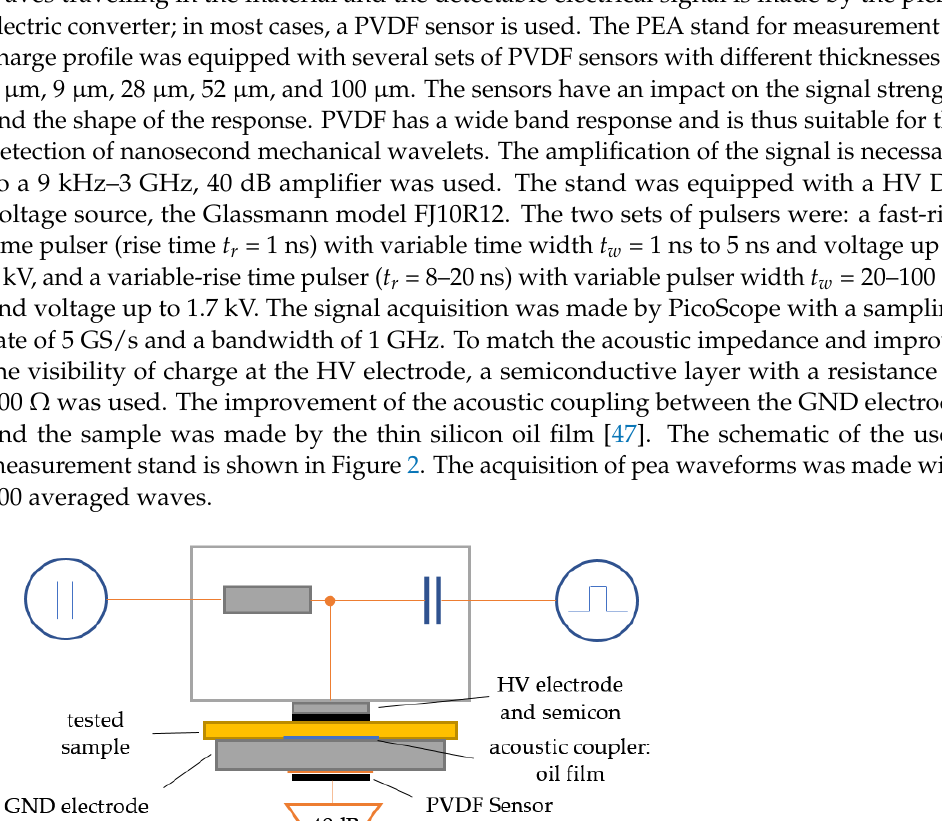
5 of 22 Figure 1. Algorithm for the determination of electrical field distribution based on the measurement of space charge profile in the flat dielectric samples.